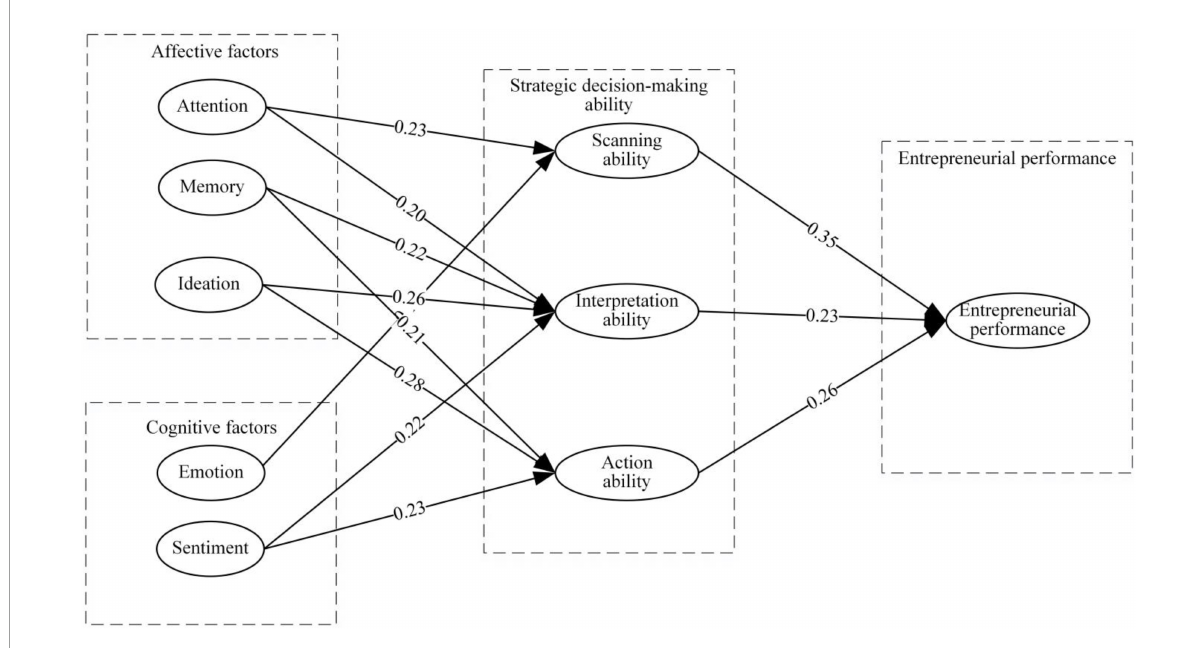
FIGURE3 Influencing factors model of strategic decision-making capacity based on structural equation modeling (SEM).